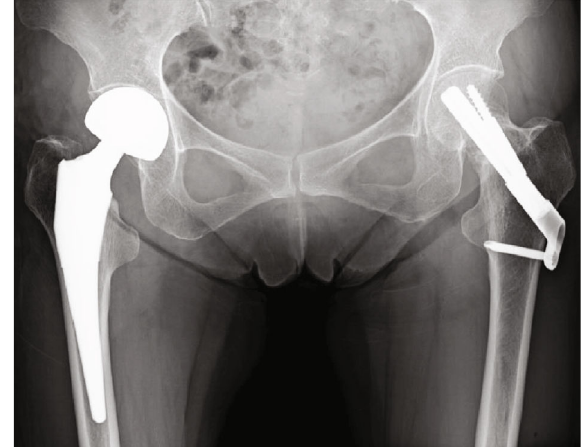
Figure 3: Postoperative radiograph demonstrating the treatment with bipolar hemiarthroplasty of the femoral neck on the right side and with osteosynthesis on the left